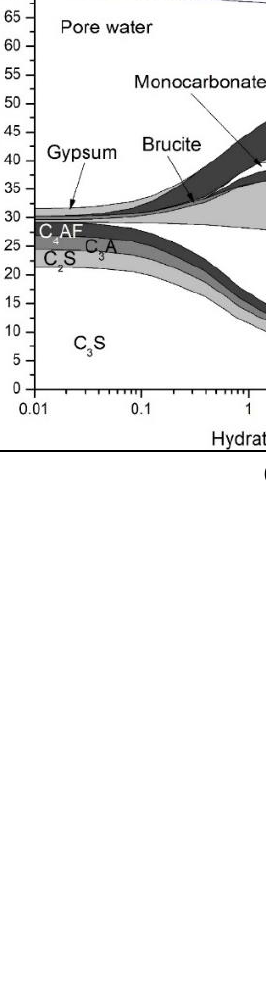
Figure 3. Predicted precipitation of AFt and AFm phases in the two cements described in Table 3.